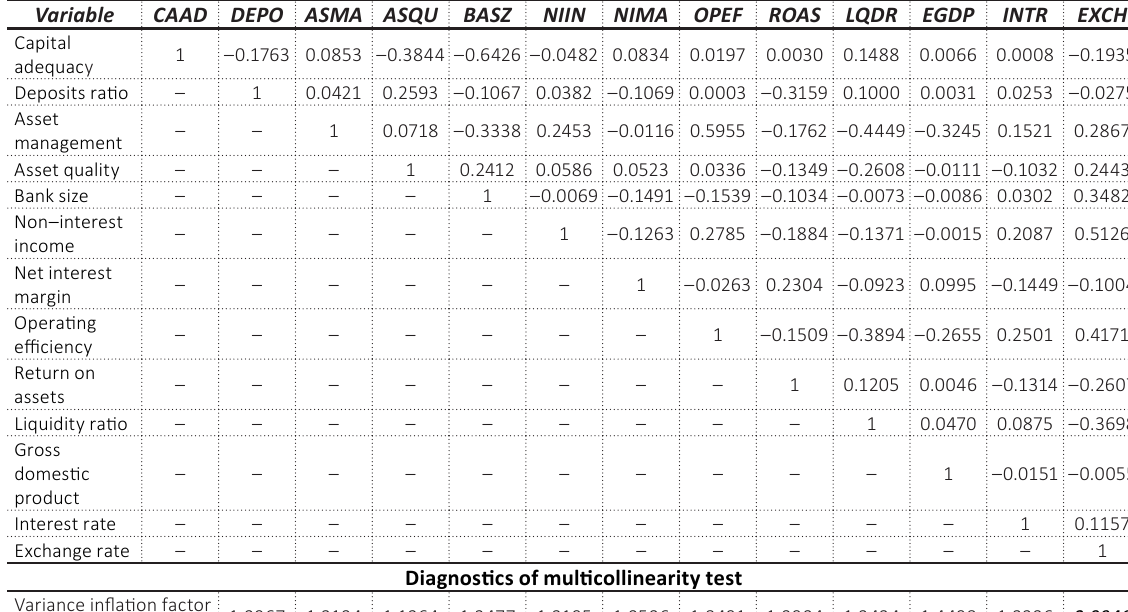
Table 3. Correlation and diagnostics of the multicollinearity test